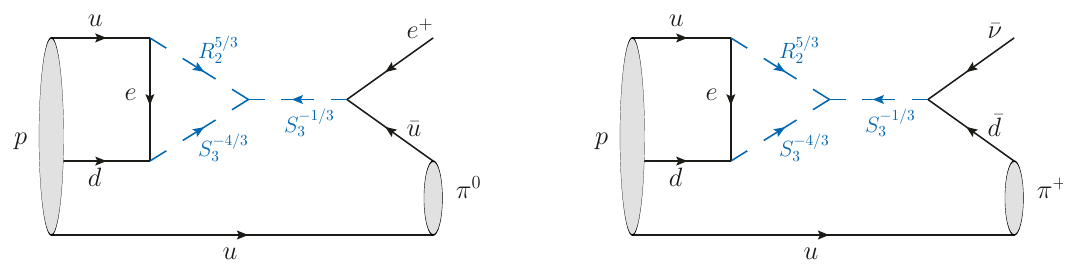
Figure 3 . One-loop level diagrams contributing to p → π 0 e + (left panel) and p → π + ¯ ν (right panel) in scenario ( d ) of table